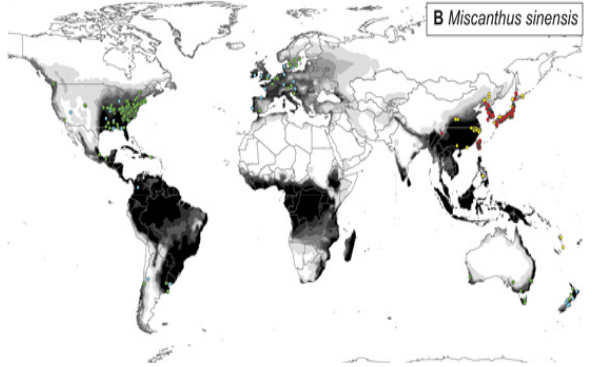
Figure 3 Distribution of M. sacchariflorus